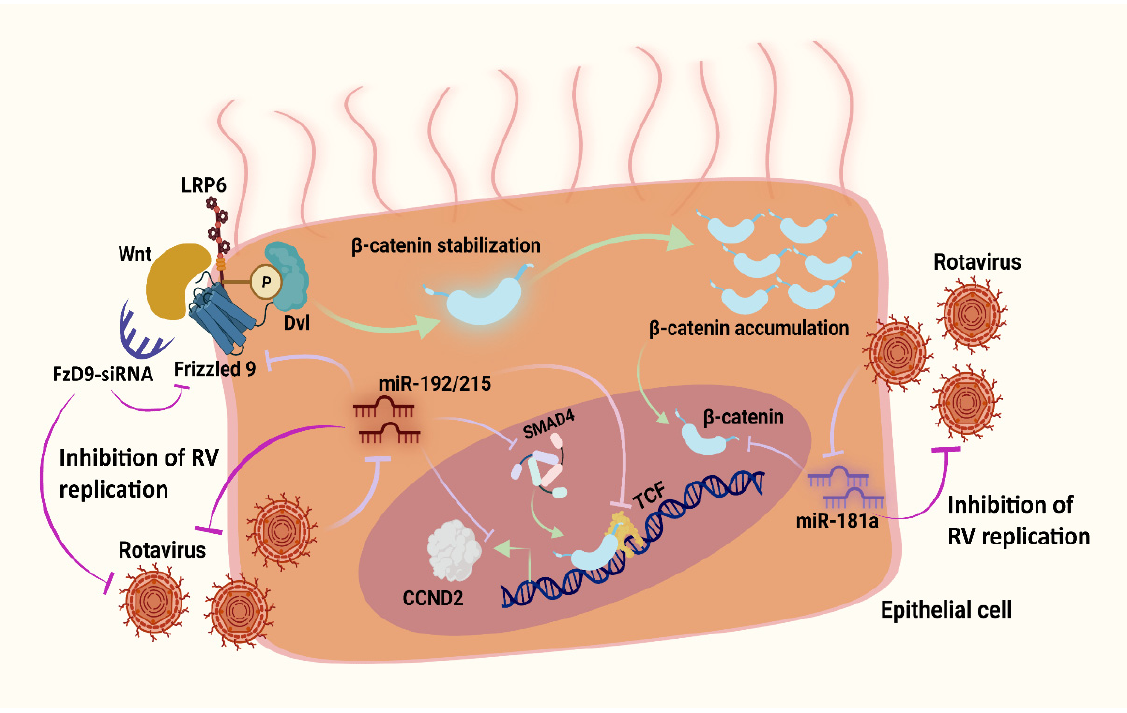
Figure 6. Schematic representation of the RV-induced changes in the Wnt/ β -catenin signaling and the role of miR-192/215, miR-181a and siRNA-FzD9 in the establishment of an anti-rotaviral state. RV triggers the activation of the Wnt/ β -catenin signaling pathway in the epithelial cells by negatively regulating the miRNAs 192, 215 and 181a. Ectopic expression of these miRNAs along with an siRNA for the receptor of the Wnt (FzD9) can significantly suppress the Wnt pathway, ultimately leading to the decrease in RV replication .